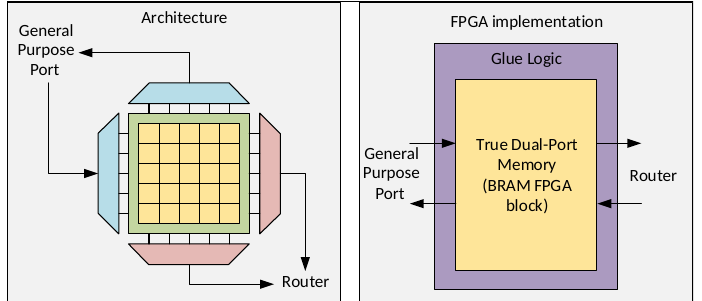
Figure 5. The pixel memory